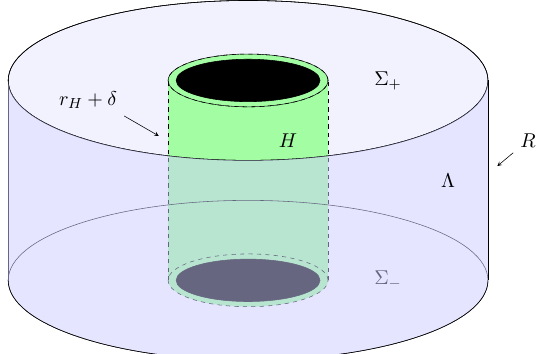
Figure 1 . A cartoon of the integration regions. Time runs upward and each S 1 of the cylinder represents an S p . The top and bottom of the cylinder are at (cid:6) T , the respective regions (cid:6) (cid:6) are the spatial integration regions. (cid:3) is blue, H is green. At a distance of (cid:14) (cid:28) R H to the horizon of the black hole, located at r = r H , we put a stretched horizon . Similarly, at R (cid:29) r H we put a